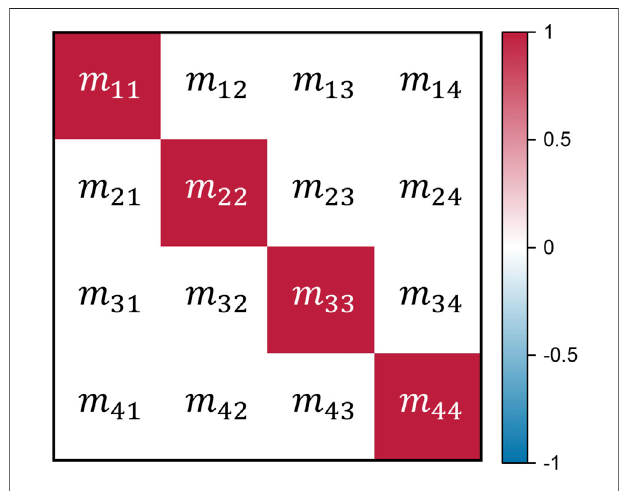
FIGURE 3 | Mueller matrix example for a transmission measurement without